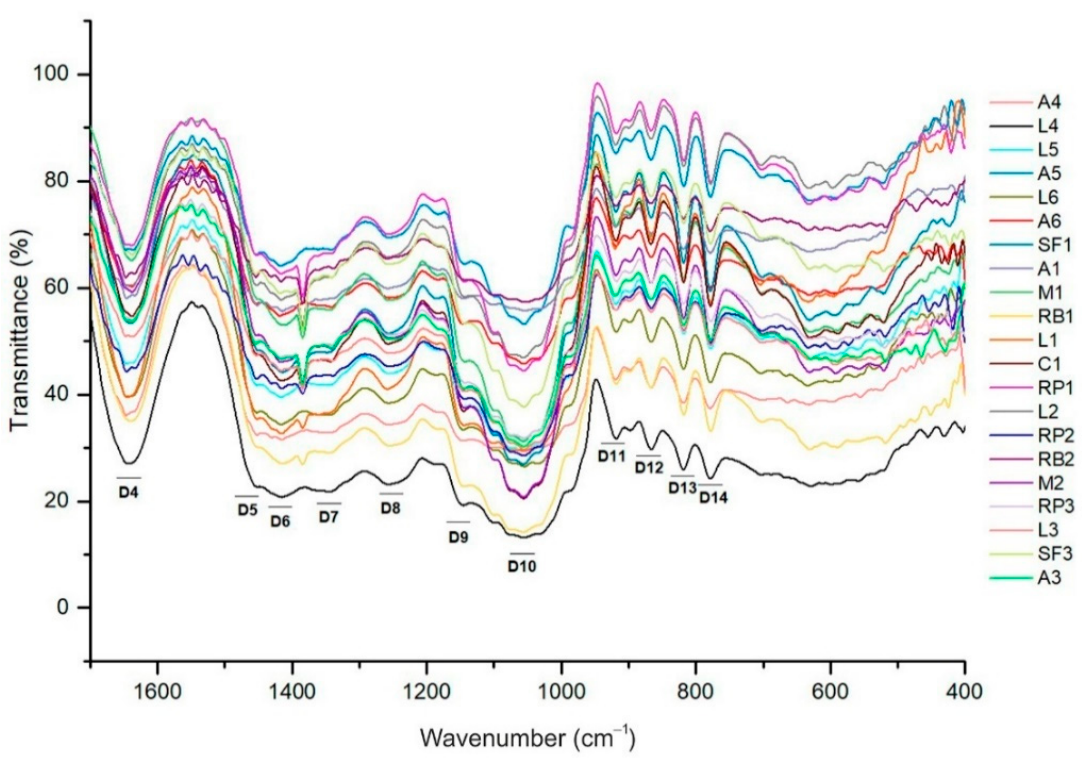
Figure 3. FTIR spectra of all studied honey samples in the spectral region from 4000 to 400 cm − 1 .